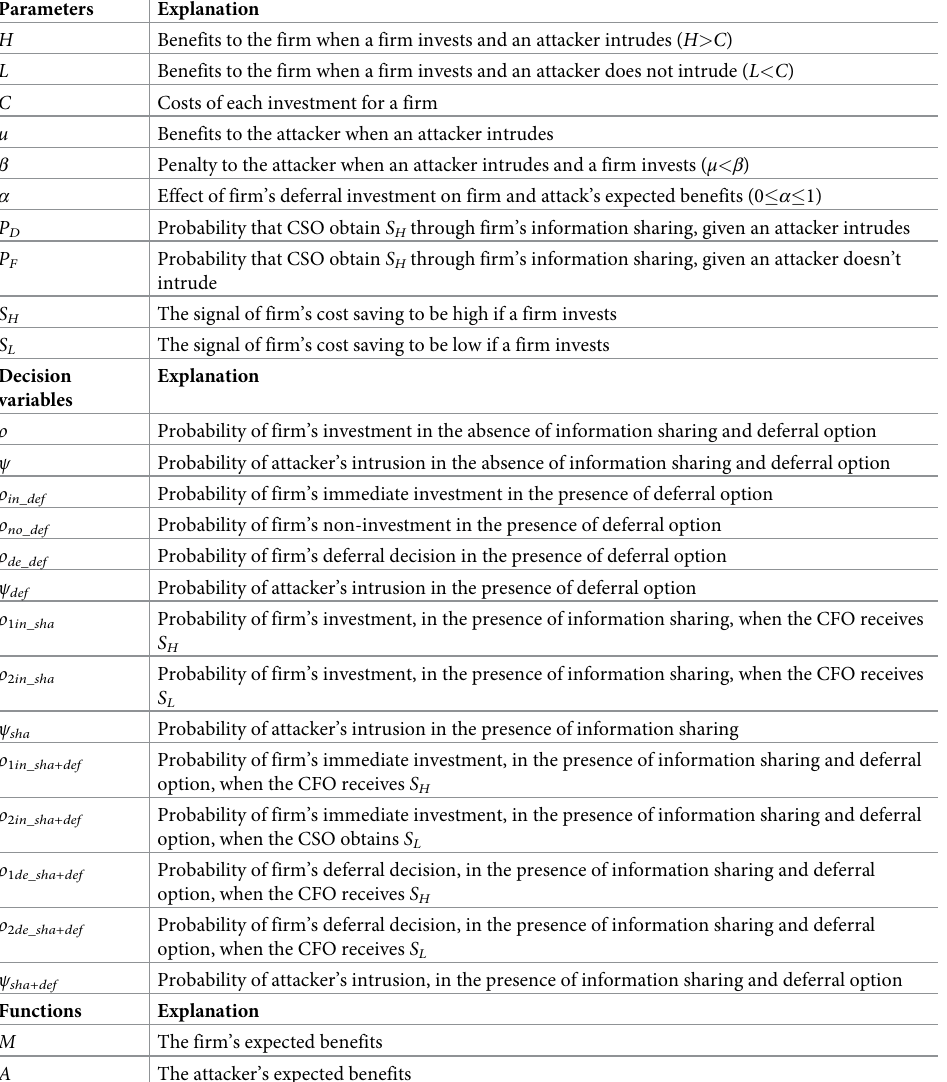
Table 1. List of notations (all the probability is between 0 and